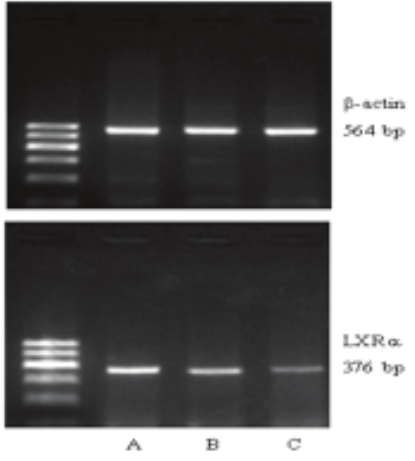
Table 3: The correlation analysis of LXRα and SREBP-1c expression